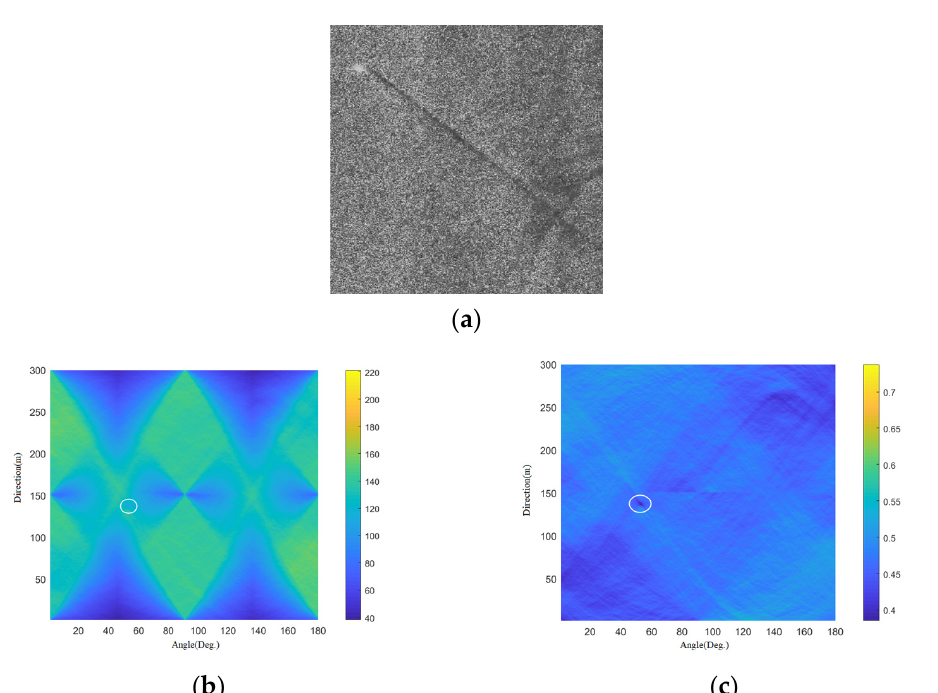
Figure 10. Wake detection results based on the Radon transform. ( a ) measured SAR wake image; ( b ) result after Radon transform processing; ( c ) result after local Radon transform processing.